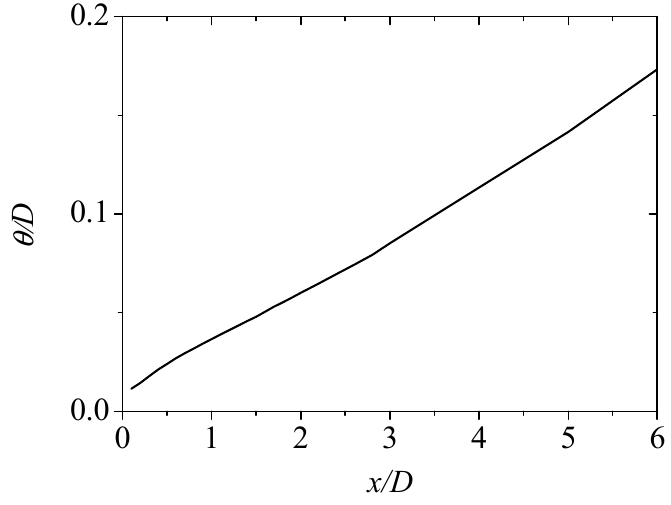
decay rate corresponds to the Kolmogorov − 5/3 spectrum, indicating the existence of the inertial subrange.